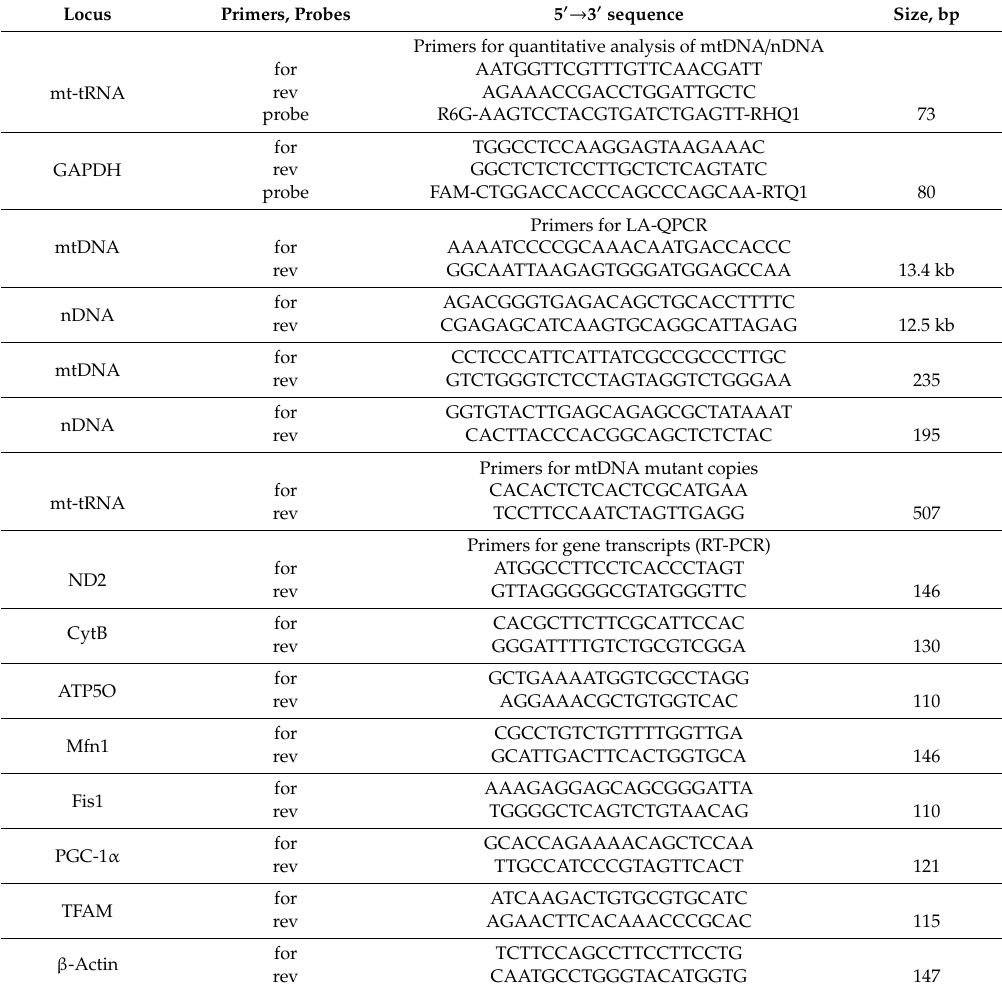
Table 1. Primers and probes used in the current